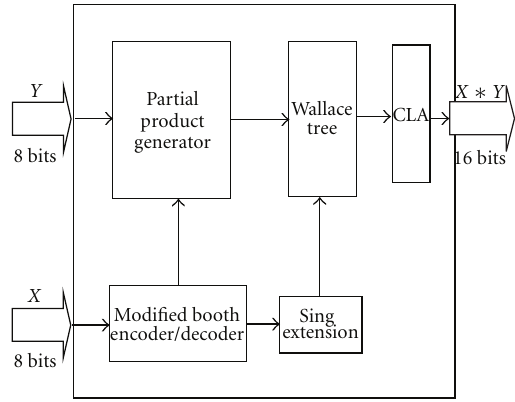
Figure 9: Block diagram of booth-encoded Wallace tree multiplier.